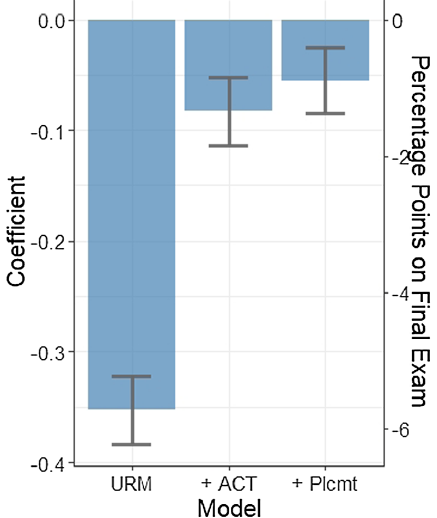
FIG. 1. Multiple linear regression coefficients of the URM variable in the binary models reported in Table IV. Coefficients represent the standardized difference in final exam performance between non-URMs (Asian and White students) and URMs (Black, Hispanic, AIAN, and NHPI students). The error bars represent the standard error for each coefficient. The URM coefficient had p < 0 . 01 for models 1 and 2 (URM alone and URM þ ACT Math, respectively), but p ¼ 0 . 069 for model 3, in which the placement test was included.